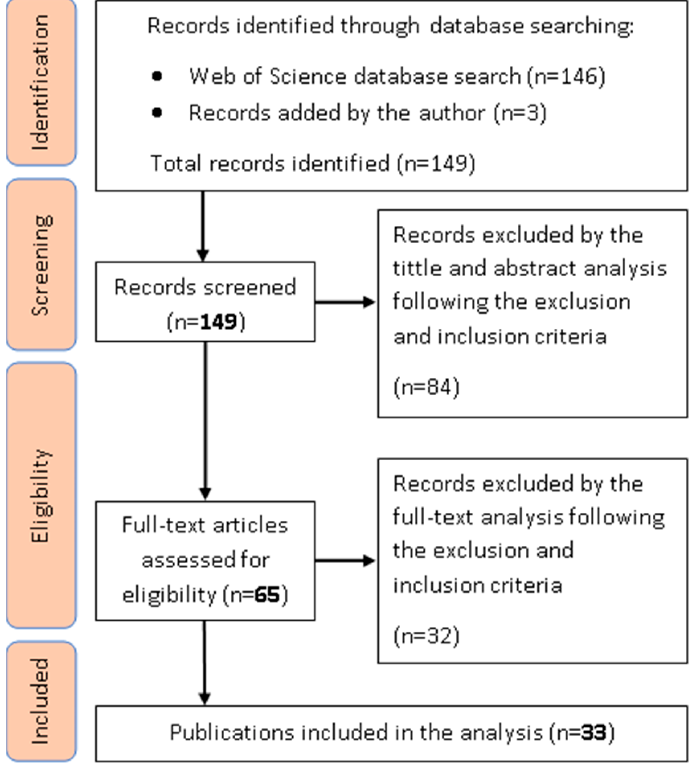
Figure 2. Flow diagram of selection and eligibility criteria of the methodology. The PRISMA rules are followed to filter publications obtained from the databases according to the eligibility criteria.